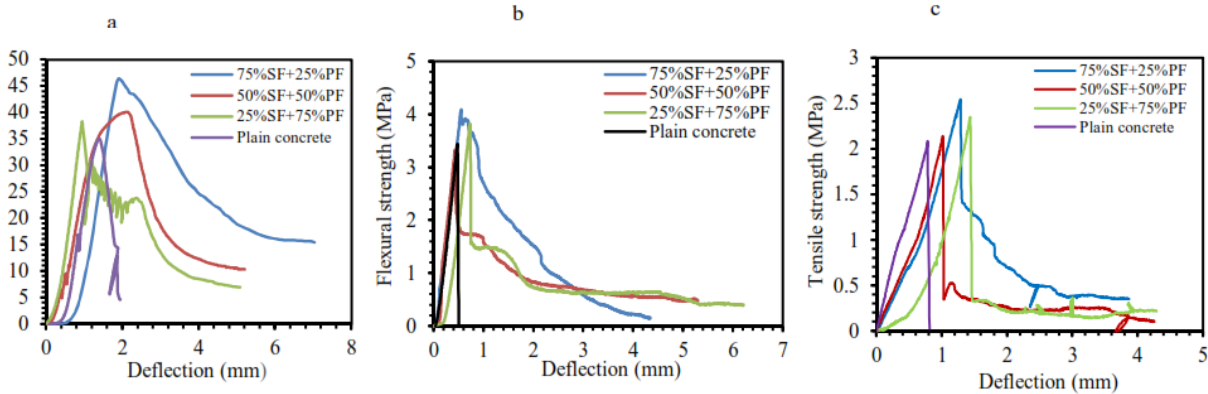
Figure 12: Results obtained from the tests at 4% of hybrid fiber amount a. compressive test b. flexural test c. direct tensile